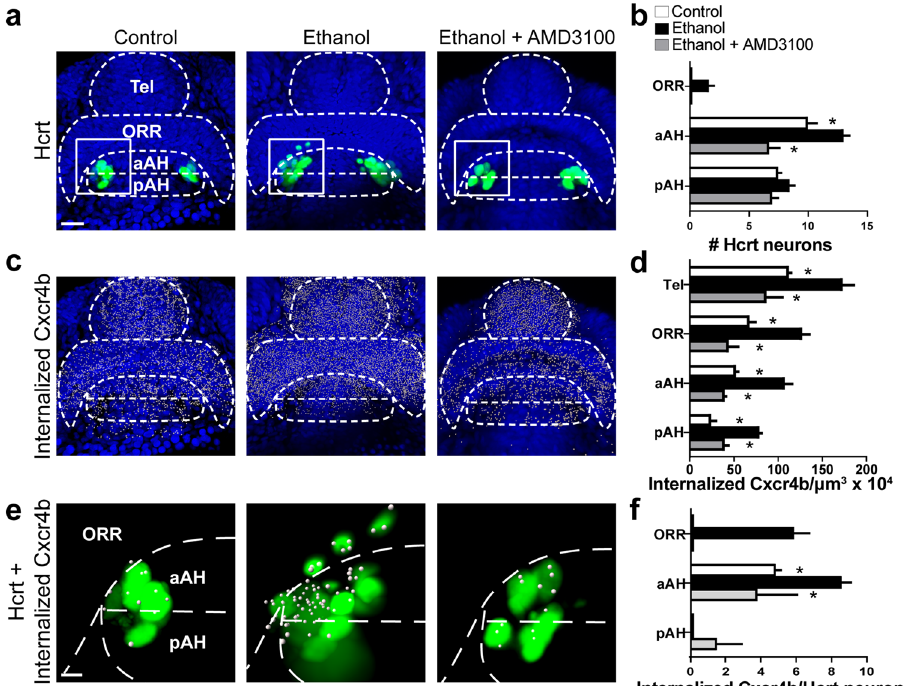
Figure 7. Effects of exposure to embryonic ethanol (0.5% v/v, 22–24 hpf) and administration of Cxcr4 antagonist AMD3100 (1 µM, 2–24 hpf) on the location of Hcrt neurons, the density of internalized Cxcr4b receptors, and the colocalization of internalized Cxcr4b with Hcrt neurons in the 28 hpf zebrafish brain. ( a ) Representative photomicrographs (×25) illustrate the zebrafish brain in a dorsal/ventral view with the pAH, aAH, ORR and Tel of the brain outlined by dashed lines, and show that ethanol compared to control increases the number of Hcrt neurons (green) at 28 hpf, only in the aAH and ectopically in the ORR, and these effects are completely blocked by AMD3100 as shown with cells counterstained with DAPI (blue). ( b ) Bar graphs (n = 4–5) show increased number of Hcrt neurons in the aAH of the ethanol group relative to the control and ethanol + AMD3100 groups, with no change occurring between groups in the pAH, and ectopically located Hcrt neurons located in the ORR are evident only in the ethanol group. ( c ) Representative photomicrographs show the density of internalized Cxcr4b receptors (white, indicated by digital “spots”) to be increased throughout the brain in the ethanol group compared to the control and ethanol + AMD3100 groups. ( d ) Bar graphs (n = 4–5) show increased density of internalized Cxcr4b in all brain regions including the pAH, aAH, ORR and Tel in the ethanol group relative to the control and ethanol + AMD3100 groups. ( e ) Enlargement of boxes at 28 hpf show ethanol treatment to increase the number of internalized Cxcr4b receptors in Hcrt neurons compared to both control and ethanol + AMD3100 groups. ( f ) Bar graphs (n = 4–5) show increased number of internalized Cxcr4b in Hcrt neurons in the aAH of the ethanol group compared to the control and ethanol + AMD3100 groups, with no change occurring between groups in the pAH, and ectopically located Hcrt neurons in the ORR of the ethanol group show a similar number of internalized Cxcr4b in Hcrt neurons relative to those in the aAH. Scale bar low magnification 20 µm; high magnification 8 µm. * p < 0.05 compared to ethanol. Results are shown as means ± standard errors. AH anterior hypothalamus, aAH anterior part of the anterior hypothalamus, pAH posterior part of the anterior hypothalamus, ORR optic recess region, Tel Telencephalon, Hcrt Hypocretin, hpf hours post